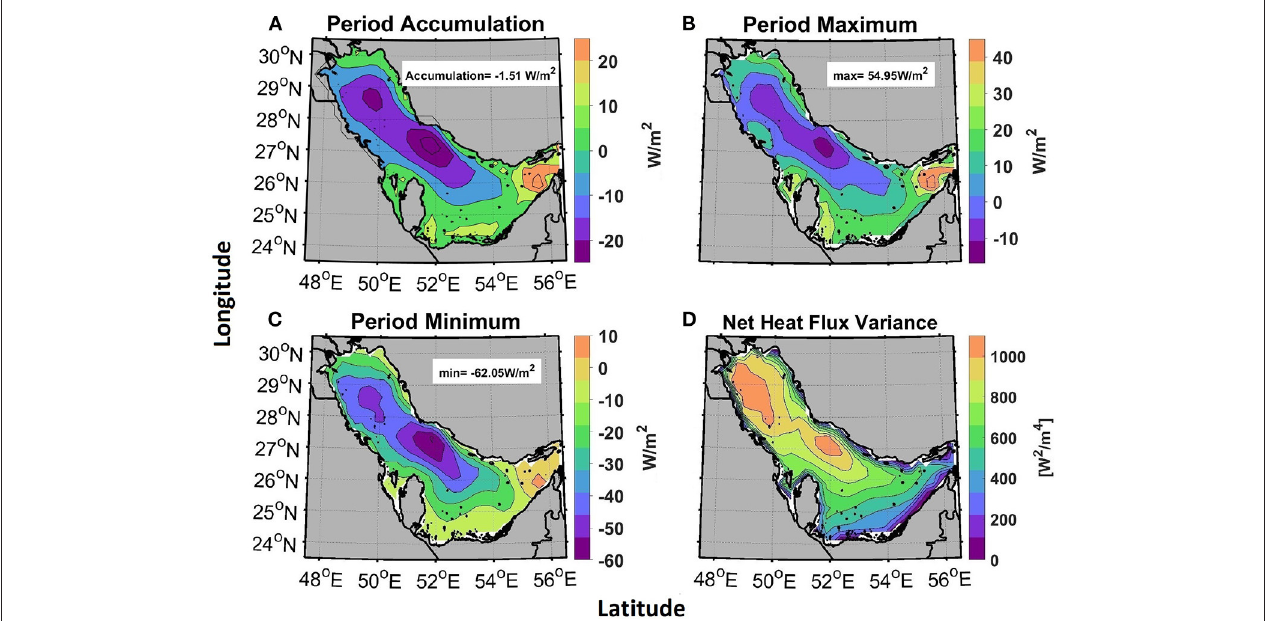
FIGURE 5 | (A) J 0 q average, (B) J 0 q minimum, (C) J 0 q maximum, and (D) J 0 q variance for 1982–2020; J 0 q time series was detrended and deseasoned prior to computing variance.